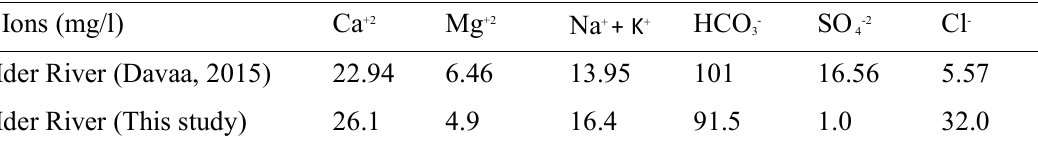
Table 4. Ion components in Ider